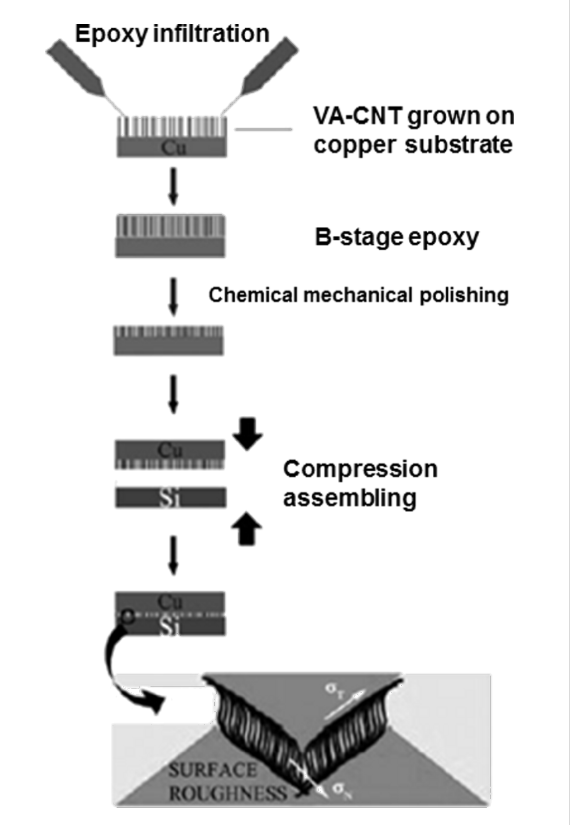
Figure 17: Illustration of the ACNT-epoxy TIM assembly process and the CNT statues at the interface. Adapted with permission from